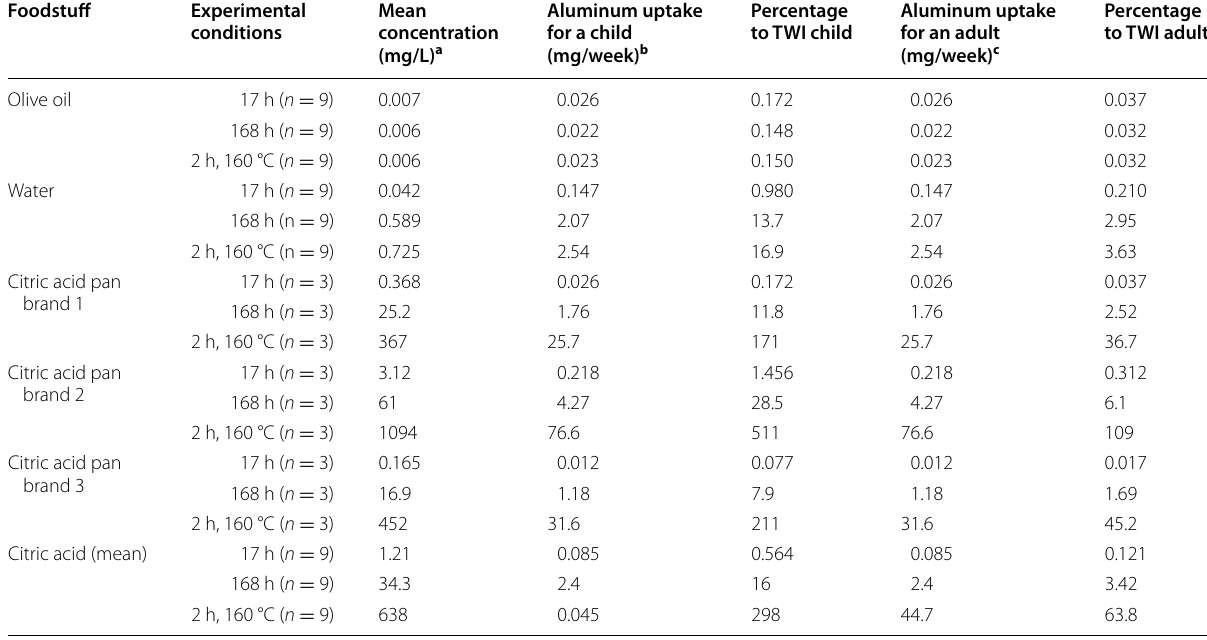
a Arithmetic mean of the results for triplicate tests of all three brands of aluminum pans b The results shown are for a child weighing 15 kg based on a daily portion of water (500 mL) or a 10 mL portion of olive oil or citric acid over a period of 1 week (7 days) c The results shown are for an adult weighing 70 kg based on a daily portion of water (500 mL) or a 10 mL portion of olive oil or citric acid over a period of 1 week (7 days)